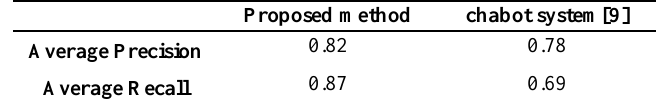
Table 3. Precision and Recall Comparisons between Proposed Method and Chabot system